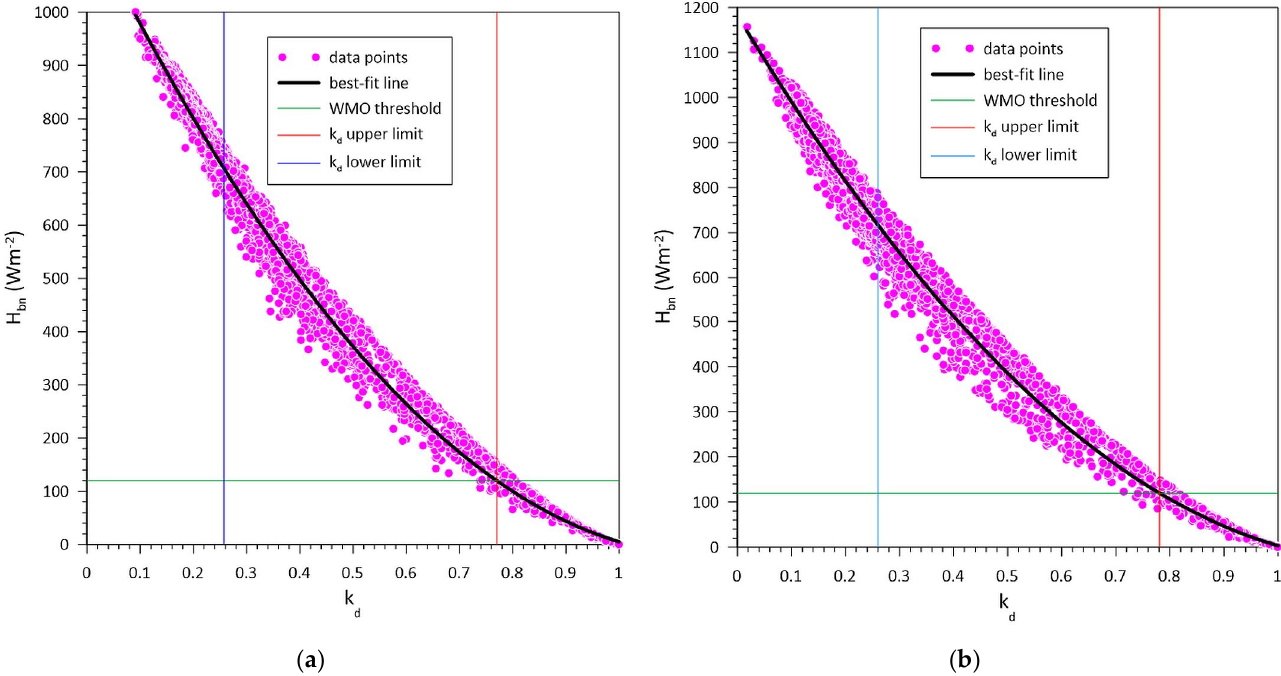
Figure 5. Determination of the k du (red line) and k dl (blue line) values for the ( a ) CAR and ( b ) DAA sites.